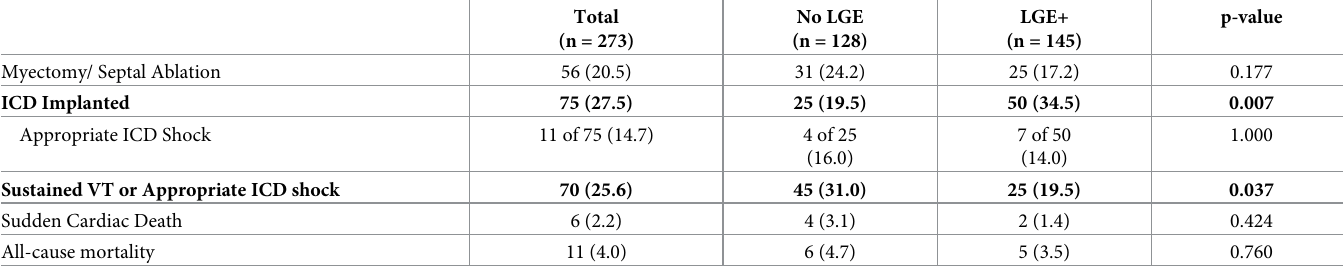
Table 4. Clinical outcomes stratified by presence of LGE.